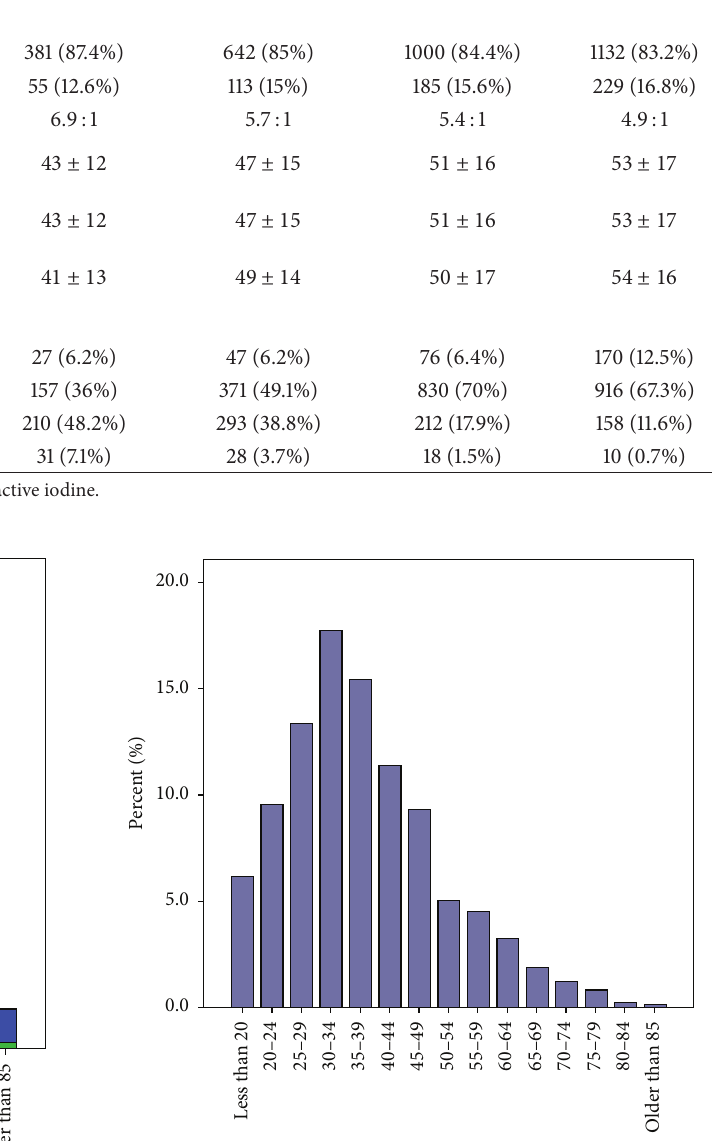
Figure 2: Age distribution of patients who underwent surgery.